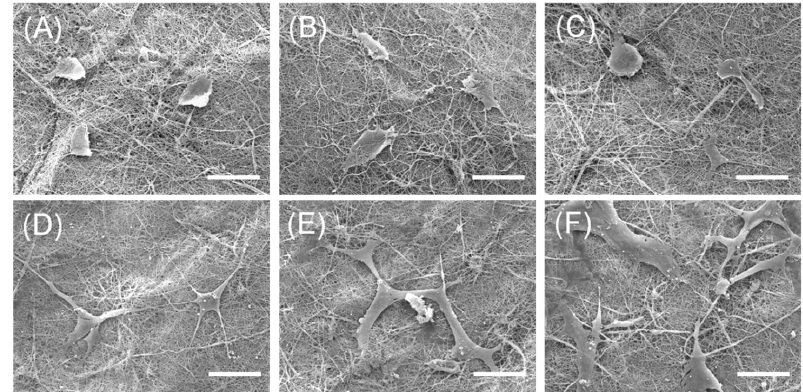
Figure 5. Representative SEM images of hMSCs cultured on neutralized CNs, P-CNs and S-CNs for seven days. ( A – C ) SEM images of hMSCs on neutralized CNs ( A ), P-CNs ( B ) and S-CNs ( C ) on Day 1; ( D – F ) hMSCs on neutralized CNs ( D ), P-CNs ( E ) and S-CNs ( F ) on Day 7. Scale bar: 50 µ m.